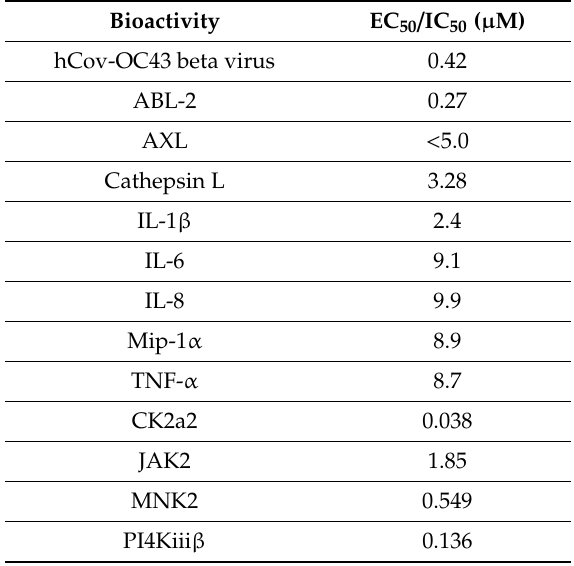
Table 1. Antiviral activity of caflanone against human coronavirus (-OC43) and viral / host factors